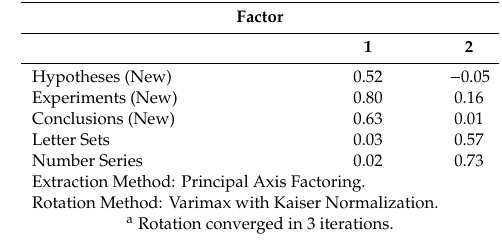
Table 4. Study 1. Rotated principal-factor matrix: New measures plus fluid-intelligence tests a .